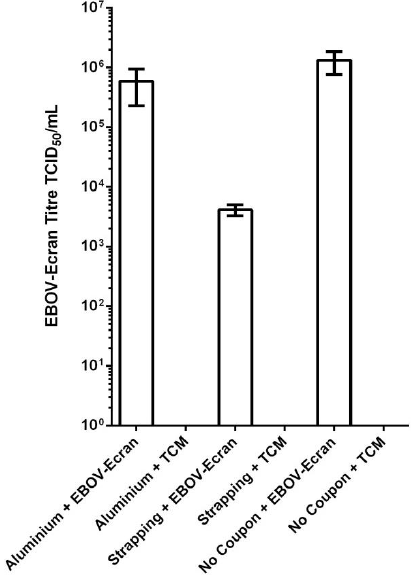
Figure 1. Recovery of Ebola virus (EBOV)-Ecran from different test surfaces. EBOV-Ecran or tissue culture media (TCM) was deposited onto 2 different coupon types, or directly onto a sterile 6-well cell culture plate (no coupon), before being recovered into 2 mL TCM by vortexing for 10 s. Samples were washed up to three times prior to enumeration. The titre of EBOV-Ecran (in TCID 50 /mL) recovered from 3 replicate tests is shown ( ˘ SEM). All TCM samples were negative for viable EBOV-Ecran. TCID 50 : 50% tissue culture infectious